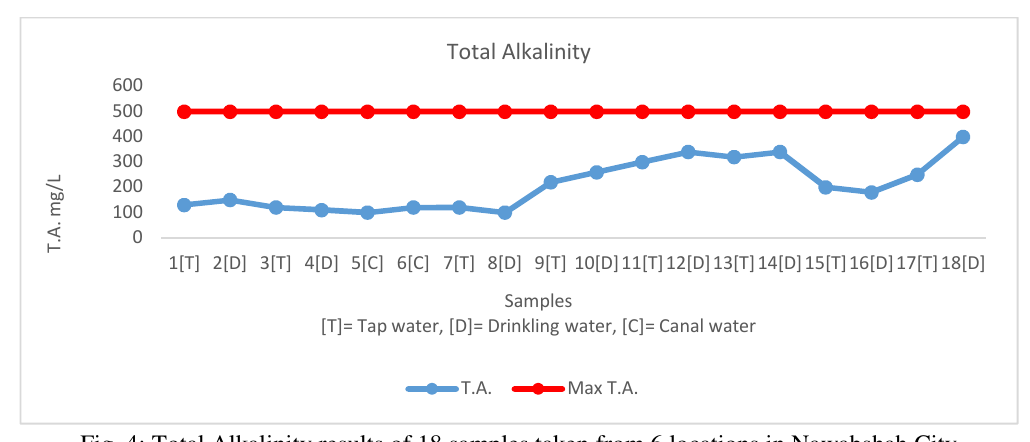
Fig. 4: Total Alkalinity results of 18 samples taken from 6 locations in Nawabshah